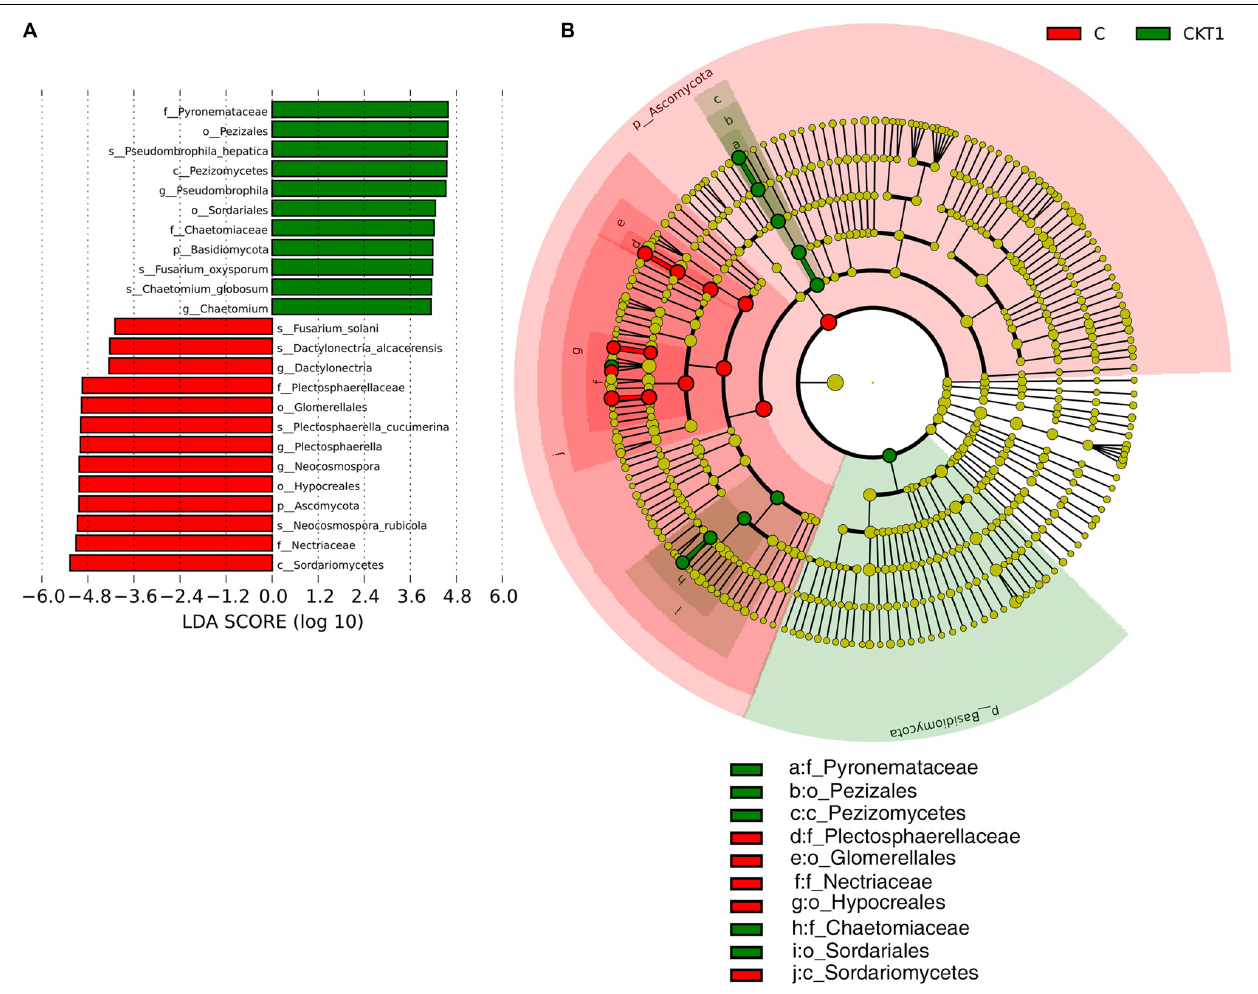
FIGURE 11 | Linear discriminant analysis identified the differentially abundant fungal taxa between soils amended with and without catalpol. (A) The fungal taxa meeting a linear discriminant analysis (LDA) significant threshold > 4 are shown. (B) Cladogram of control and catalpol treatments. CKT1 represents control soil without catalpol. C represents soil amended with catalpol for 60